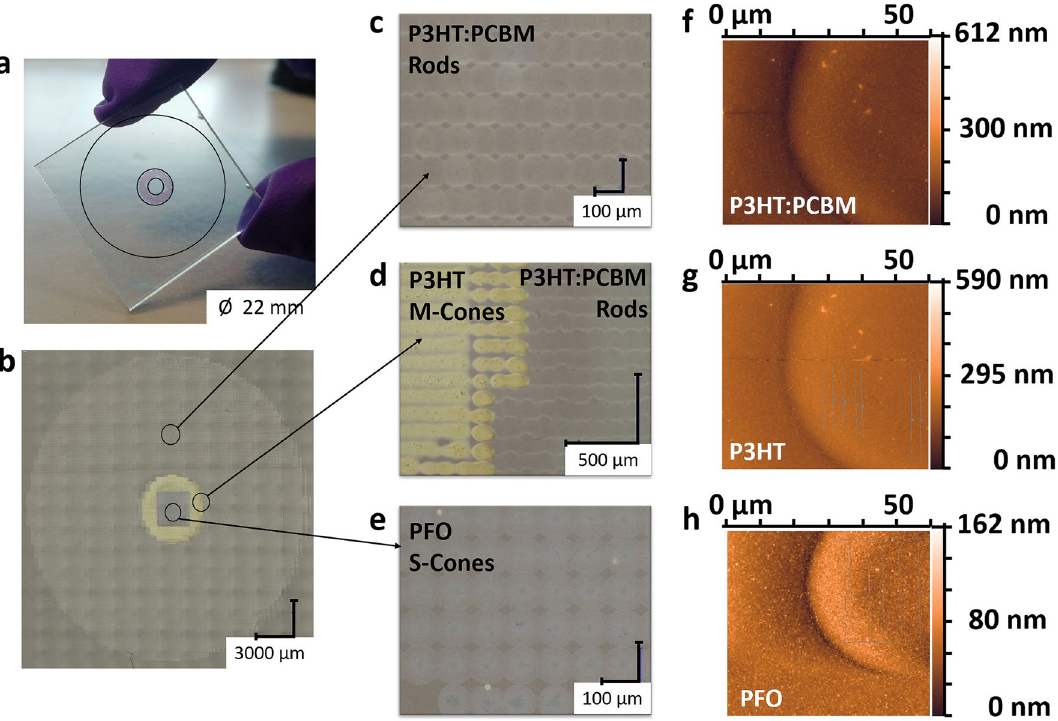
Figure 5. Inkjet-printed artificial retina device prototype and related optical microscopy analysis. ( a ) Device picture and ( b ) optical microscopy image of polymer inkjet-printed artificial retina showing, ( c – e ) different regions of the concentrically organized polymer pixels. ( f – h ) AFM images of photosensitive round polymer pixels. AFM characterisation was also used for thickness and roughness measurements of the